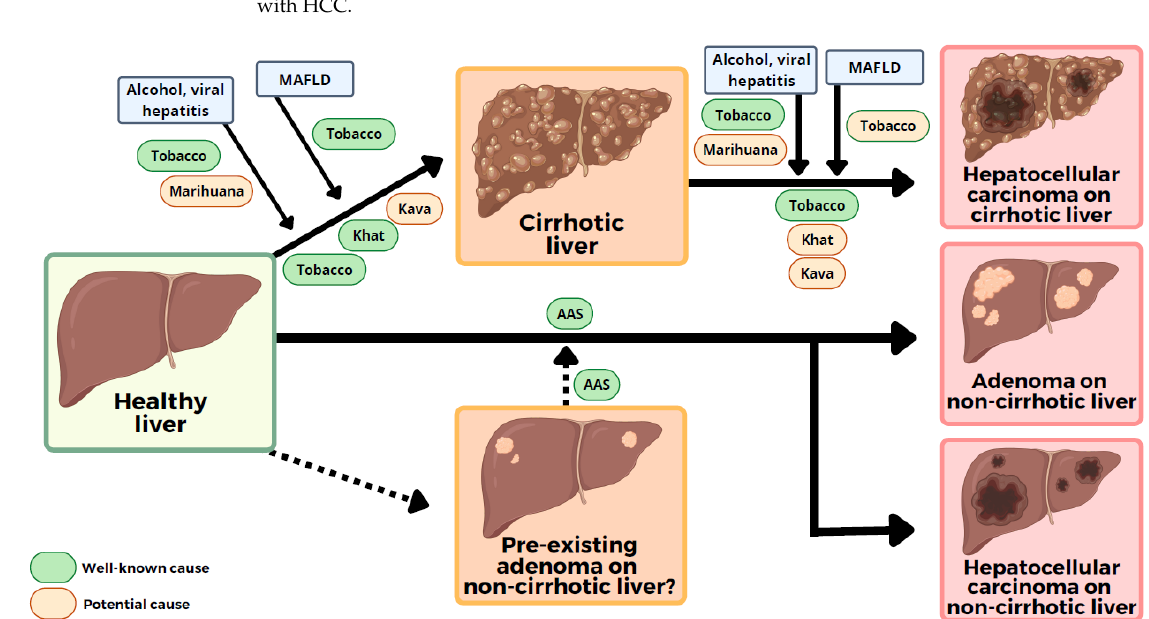
Figure 1. Well-defined and potential pathways for the development of recreational-drug-related liver tumors . This figure shows the potential role of recreational drugs in the development of liver tumor or their interactions in the cirrhosis–hepatoma sequence. Green: well-known cause of liver tumor. Orange: potential cause of liver tumor. Abbreviations: AAS, anabolic androgenic steroid; MAFLD, metabolic-associated fatty liver disease. Created with BioRender.com.